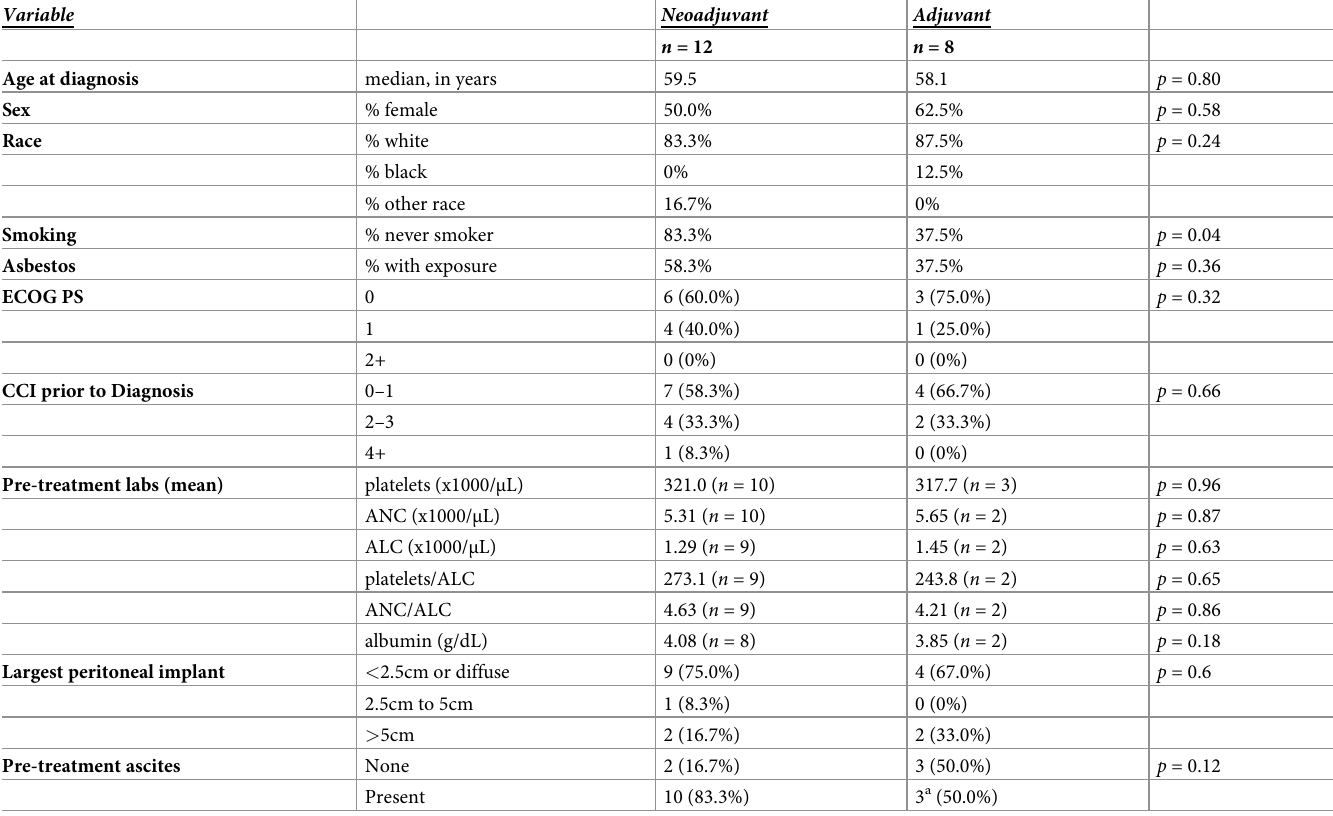
Table 3. Comparison of neoadjuvant and adjuvant patients.